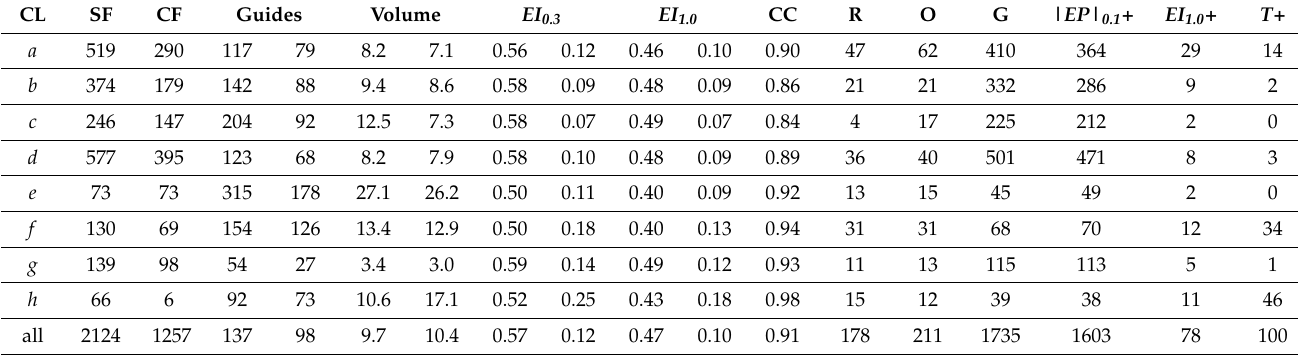
Table 5. Results of application of EP algorithm to SCOP 2.08 domain superfamily representatives using m = 3. CL—SCOP class, SF—number of superfamilies, CF—number of common folds, Guides—average number of guide effective atoms, Volume—average ellipsoid volume coefficient ( V ), EI 0.3 and EI 1.0 —average ellipsoid indexes, CC— EI 0.3 vs. EI 1.0 correlation coefficient, R—number of “red” domains (non-globular), O—number of “orange” domains (partially globular), G—number of “green” domains (globular), |EP| 0.1 +—number of domains where |EP| 0.1 ≥ 0.5 (globular center of the structure), EI 1.0 +—number of domains where EI 1.0 > EI 0.3 , T +—number of domains with T coefficient larger or equal 2 (elongated structure). Right columns under Guides, Volume, EI 0.3 and EI 1.0 list standard deviations for mean values to their